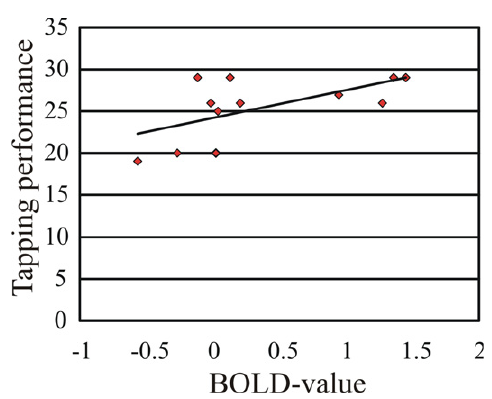
Figure 3 | The correlation between tapping performance inside the scan- ner on the trained sequence and the BOLD signal change in pre-motor cortex (beta-value) was signifi